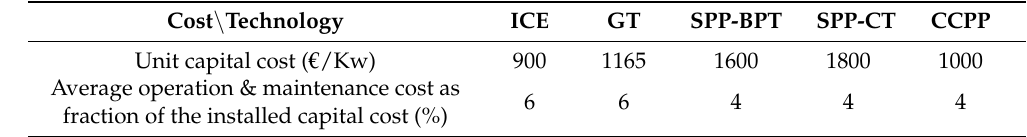
Table 6. Input data for economic analysis (different technologies).